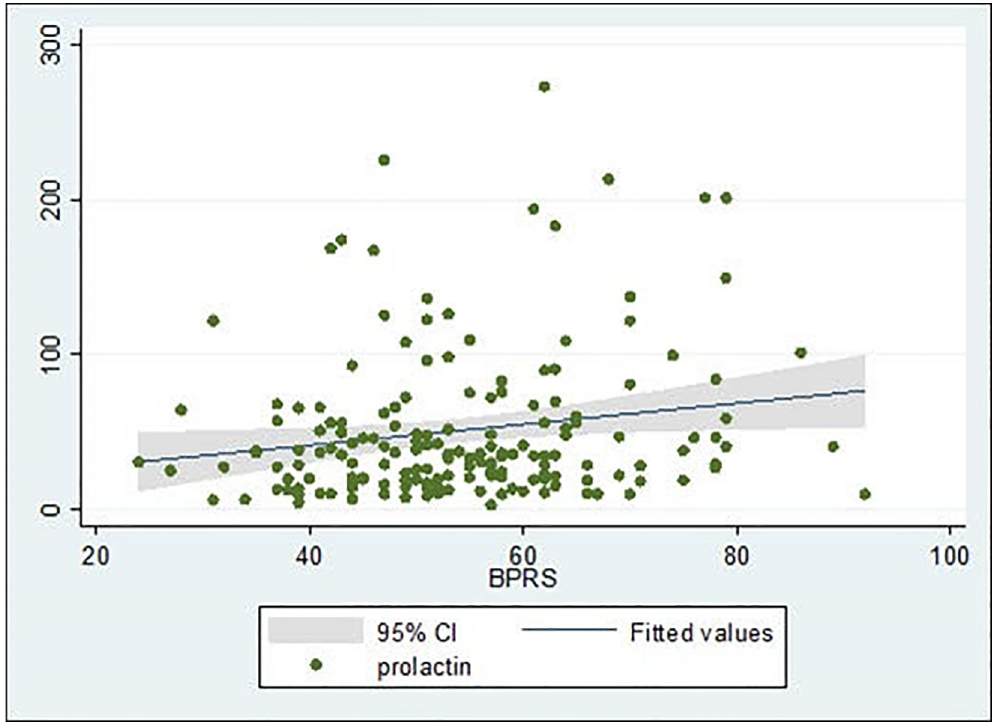
Fig 1. Correlation between BPRS scores and prolactin